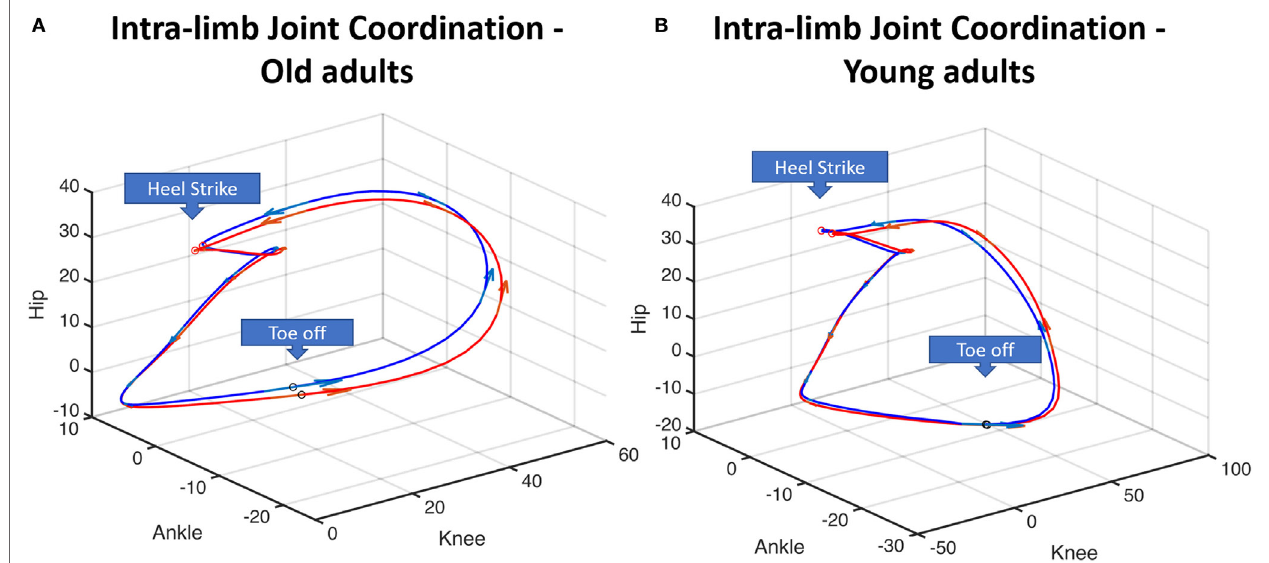
FigUre 3 | Illustration of hip angle–ankle angle–knee angle intra-limb coordination patterns for the old adults (a) and the young adults (b) . Blue line represents the relative hip-knee-ankle position averaged for the group for the first stage; red line represents the relative hip-knee-ankle position averaged for the group for the fifth/ last stage. These two stages are displayed to highlight the differences induced by the activity. Arrows indicate the direction of the